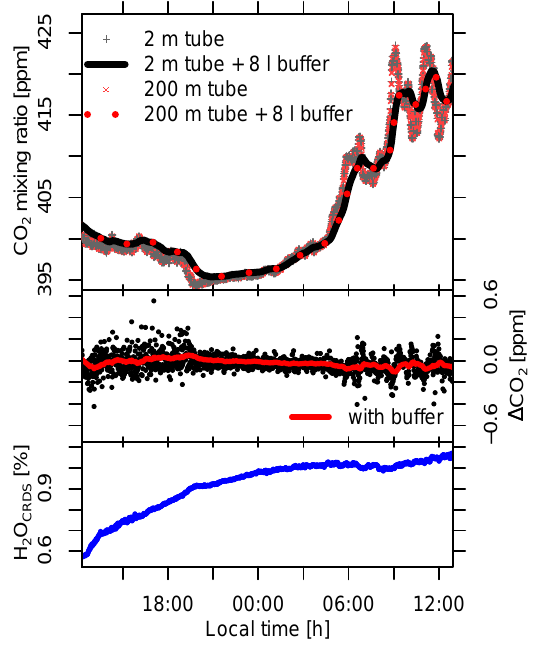
Fig. 4. Comparison of CO 2 measurement through 200m and 2m wet tubes (only a subset of data